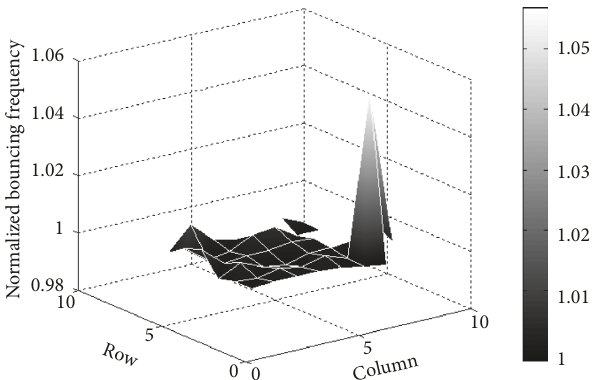
Figure 7: Normalized achieved bouncing frequencies for partic- ipants with 1m × 1m spacing at 1.8Hz in one test.